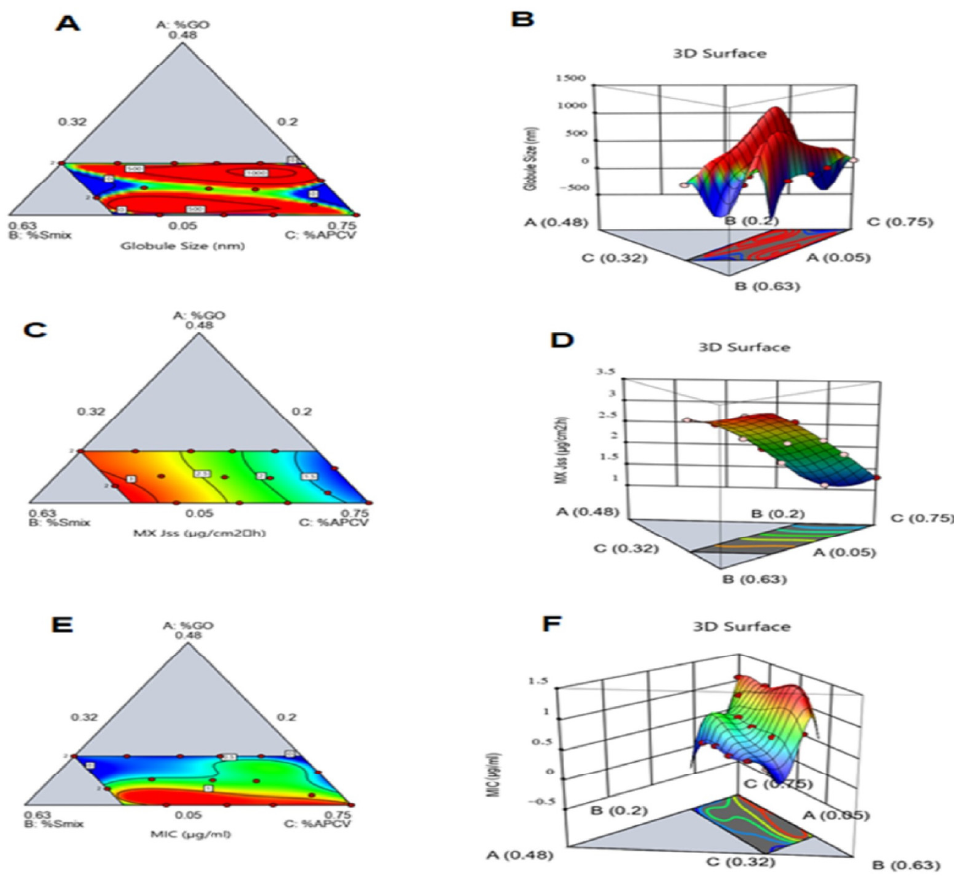
Figure 2. Statistical design plots for the droplet size, MX Jss, and MIC of MX-GO-APCV nanoemul- sions: ( A ) contour plot for droplet size, ( B ) response surface plot for droplet size, ( C ) contour plot for MX Jss, ( D ) response surface plot for MX Jss, ( E ) contour plot for MIC, and ( F ) response surface plot for